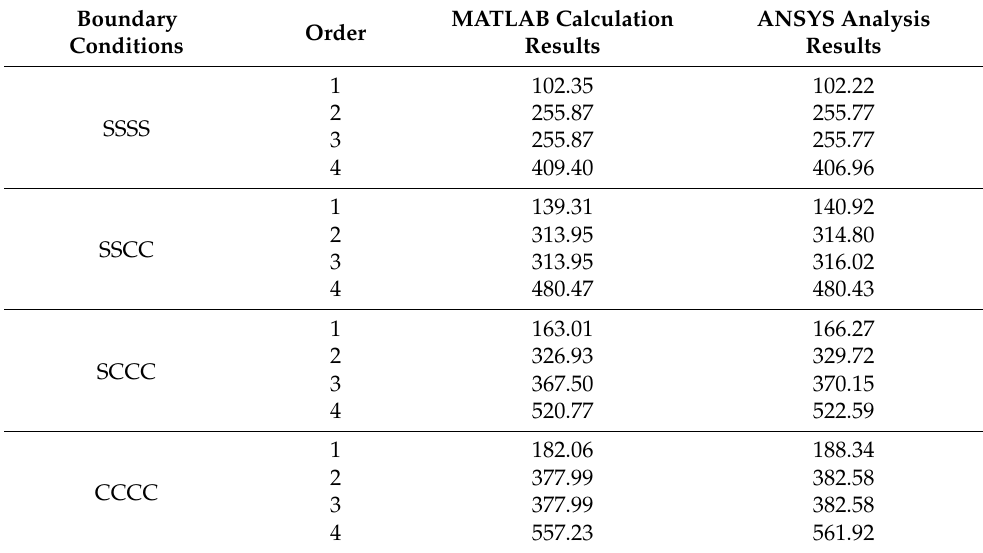
Table 2. Comparison of free vibration frequency ω (rad/s) results between MATLAB and ANSYS. Boundary Conditions Order MATLAB Calculation Results ANSYS Analysis Results